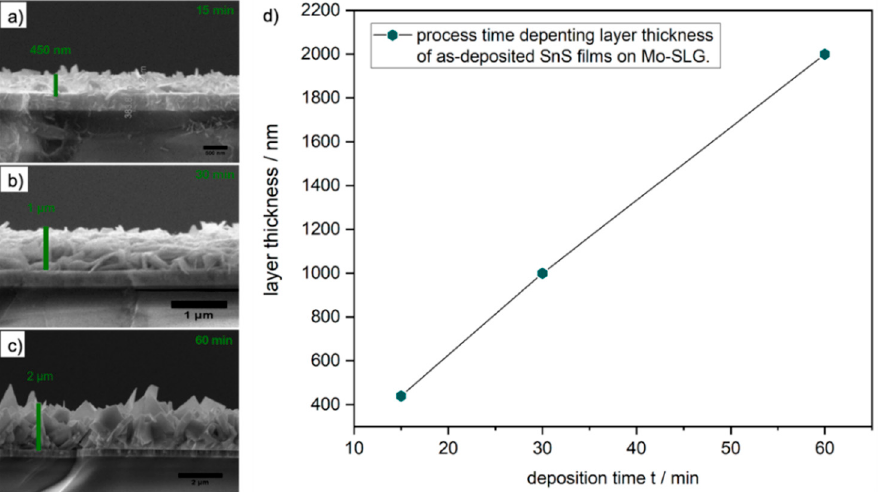
Figure 8. Cross-sectional view on the SnS layer thickness obtained after ( a ) 15 min, ( b ) 30 min, ( c ) 60 min, and ( d ) plot of time-depending layer thickness of as-deposited SnS films .